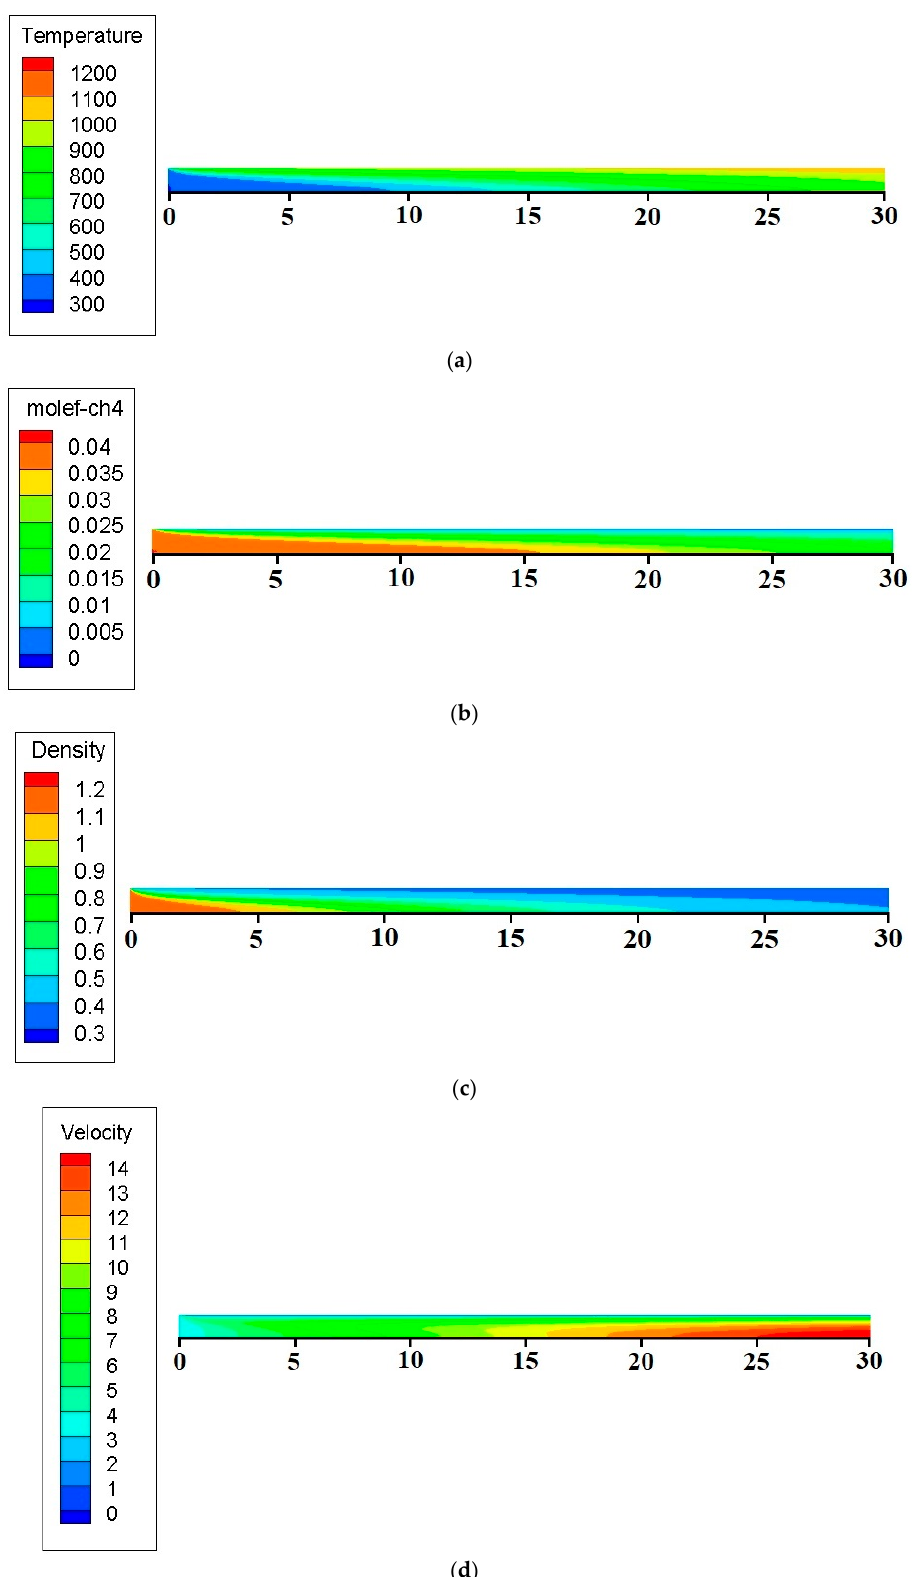
Figure 21. Temperature, concentration, density, and flow velocity distribution, 2 MPa, 4% of CH 4 . ( a ) Temperature distribution. ( b ) Methane concentration distribution. ( c ) Density distribution. ( d ) Velocity distribution.